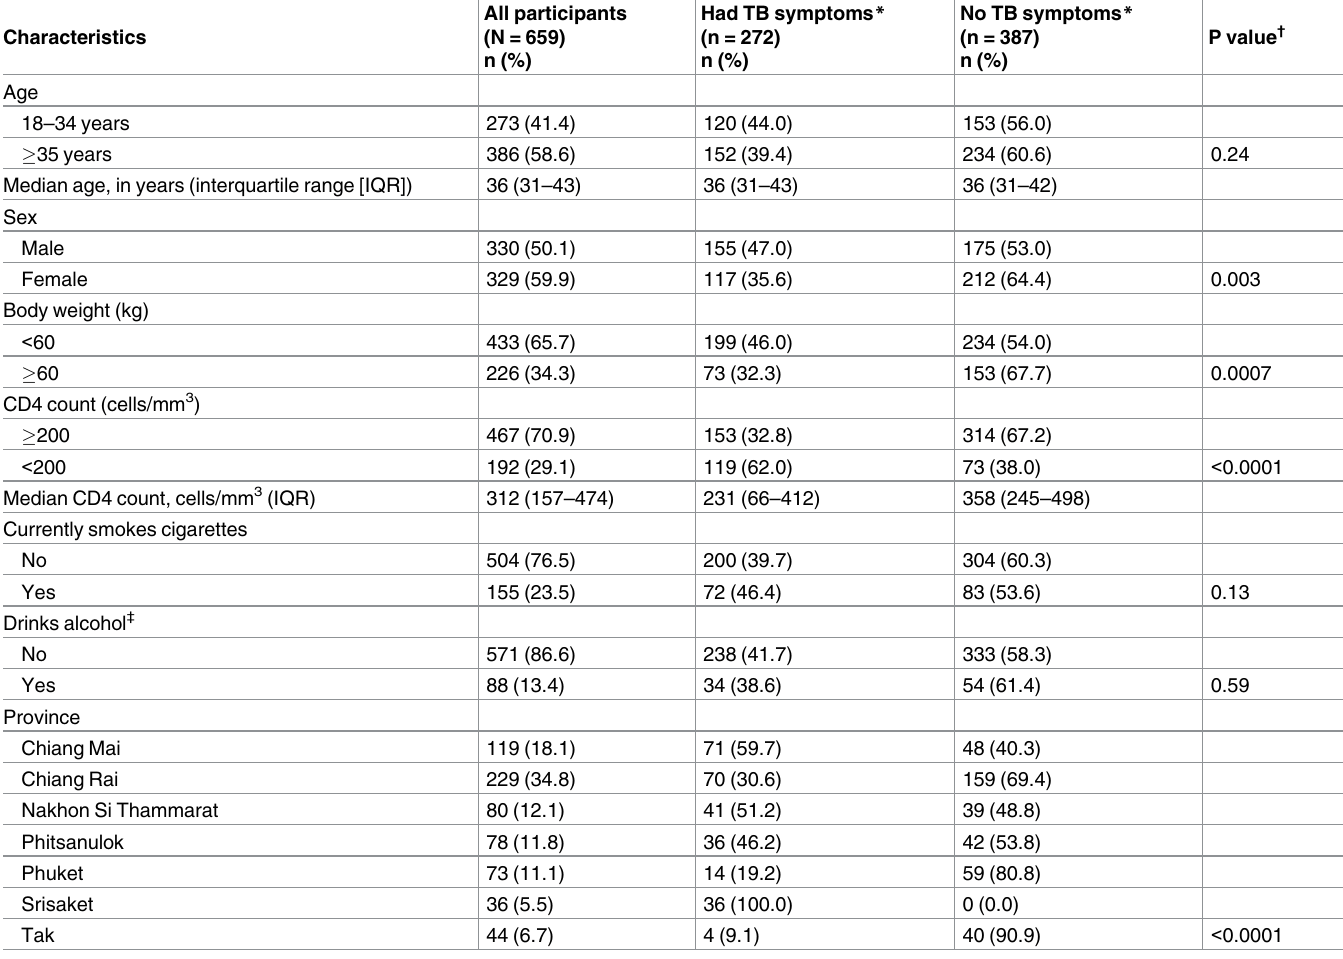
Table 1. Baseline characteristics of people living with HIV assessedfor symptoms of tuberculosis * at seven hospitals in Thailand, 2010–2011.